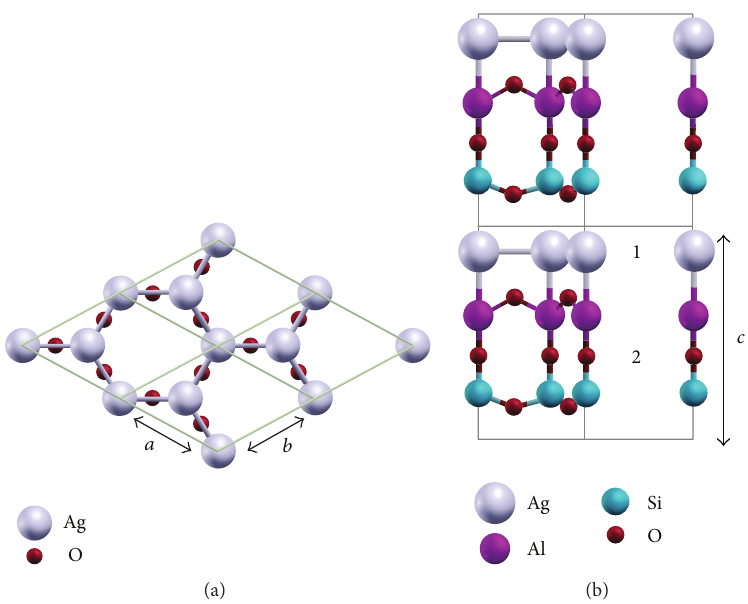
Figure 1: Silver aluminosilicate: (a) top view and (b) side